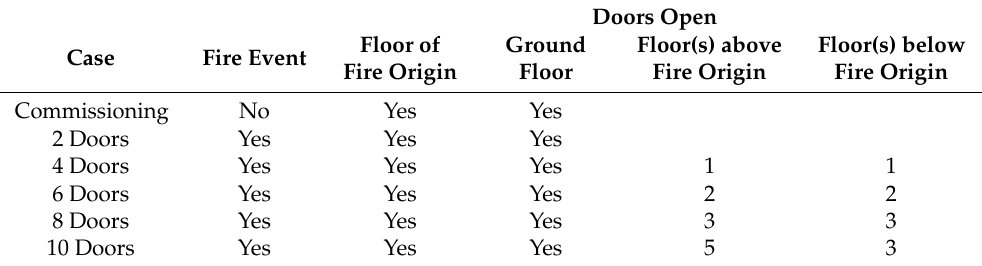
Table 3. Simulated